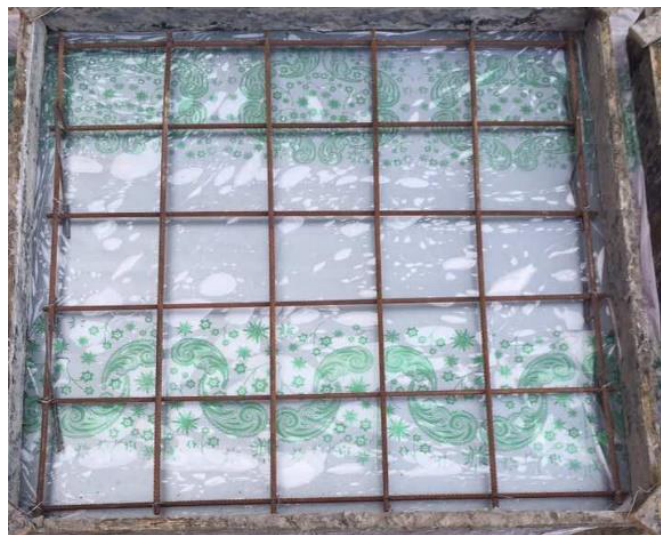
Figure 5. Steel reinforcement and mold.